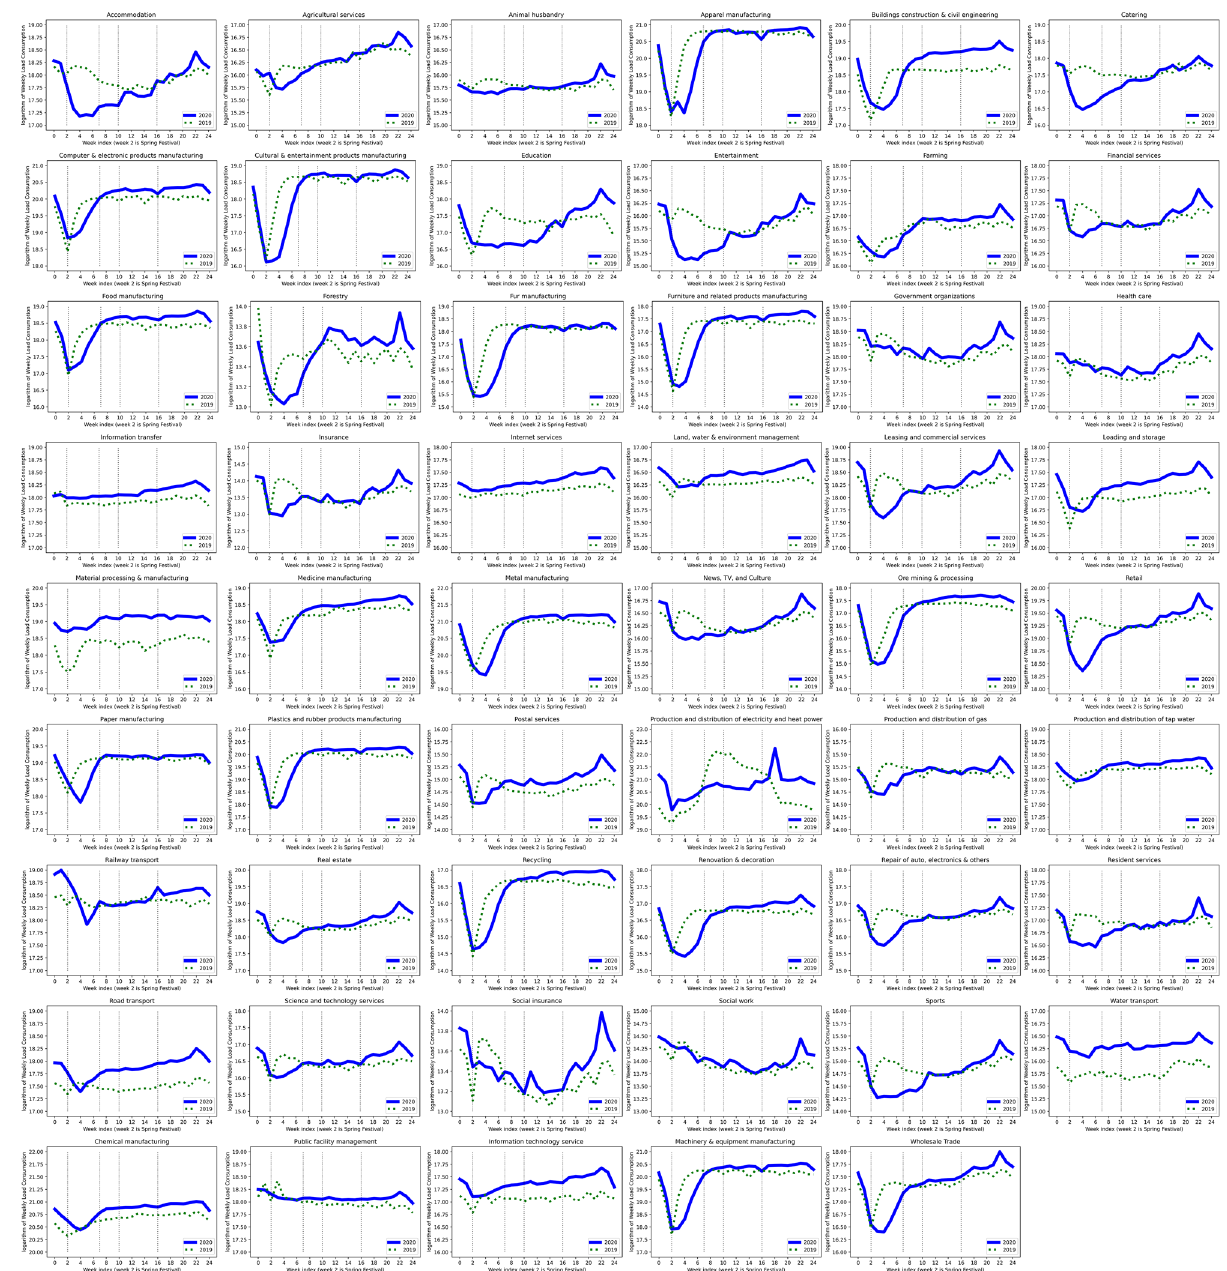
Figure 7. The Comparison of the Weekly Electricity Consumption of 53 Sub-sectors in 2019 and